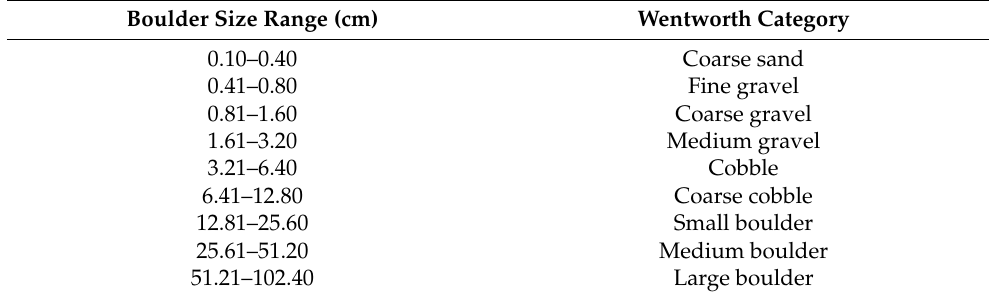
Table 1. Overview of sampled rock size categories from boulder beaches in southeastern Australia.